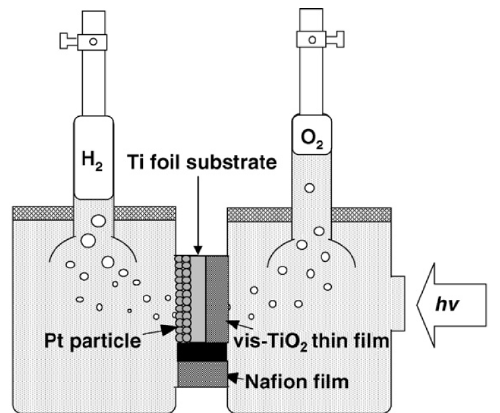
Figure 8. H-type reaction system for photocatalytic water splitting Reprinted from ref [64], Copyright (2007), with permission from